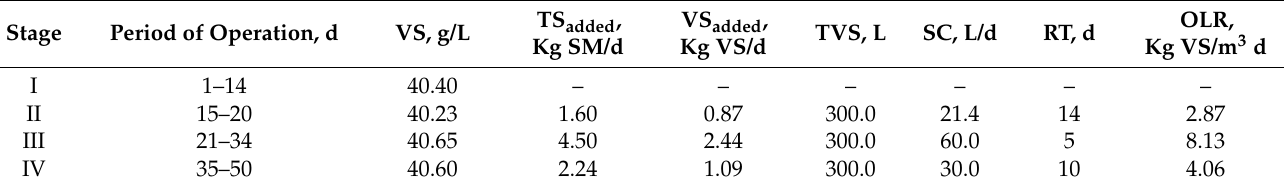
Table 5. Three-stage bioreactor performance